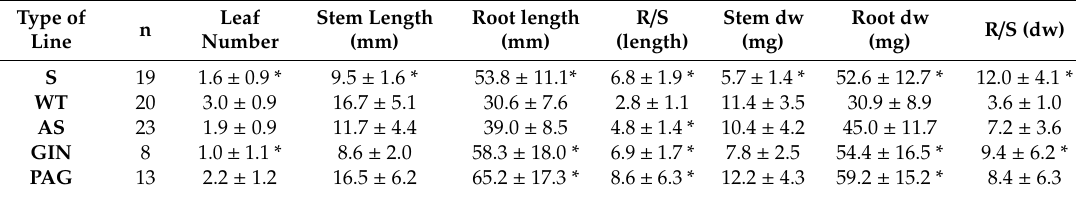
Table 2. Transgenic walnut plantlet development. Leaf numbers, lengths, root and shoot dry weights and root / shoot ratios (R / S) were obtained for each plantlet. For statistical analysis, the data were gathered according to the types of line they originated from: S (S lines), WT (I1C wild-type) and other types of transgenic lines (GIN, PAG and AS). The total number of plantlets analyzed for each type of line is indicated